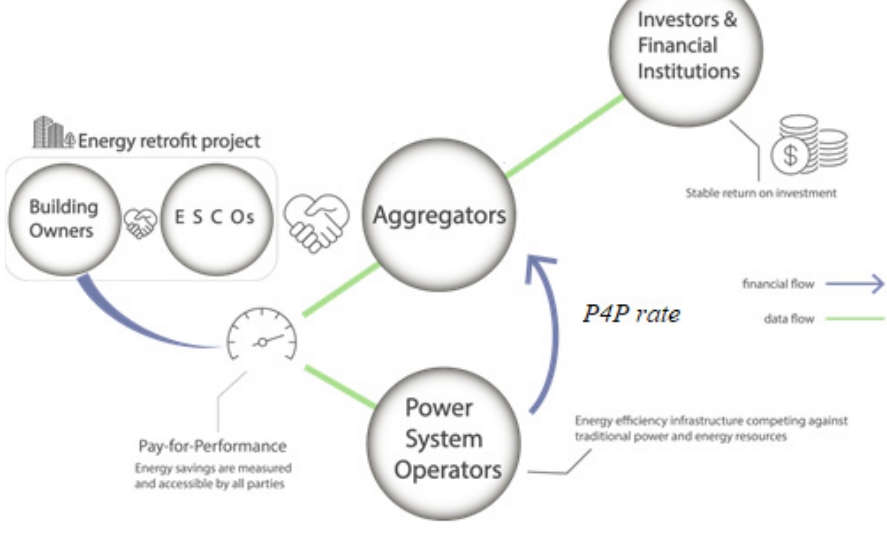
Figure 3. The energy efficiency value chain of the SENSEI business model and the integration of P4P